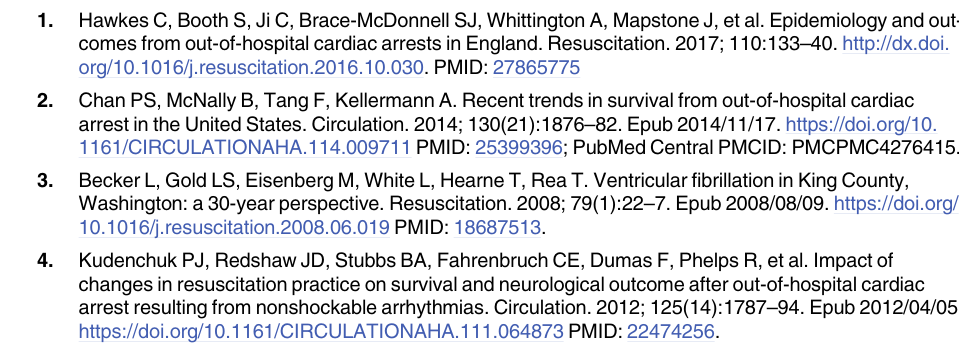
S2 Table. Univariate logistic regression of prognostic factors on survival at hospital dis-